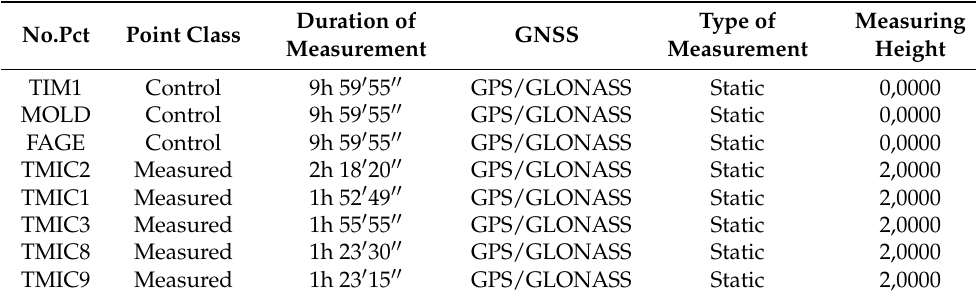
Table 6. Fulfillment or non-fulfilment of ambiguities, Topolov ă ¸tu Mic, Timis